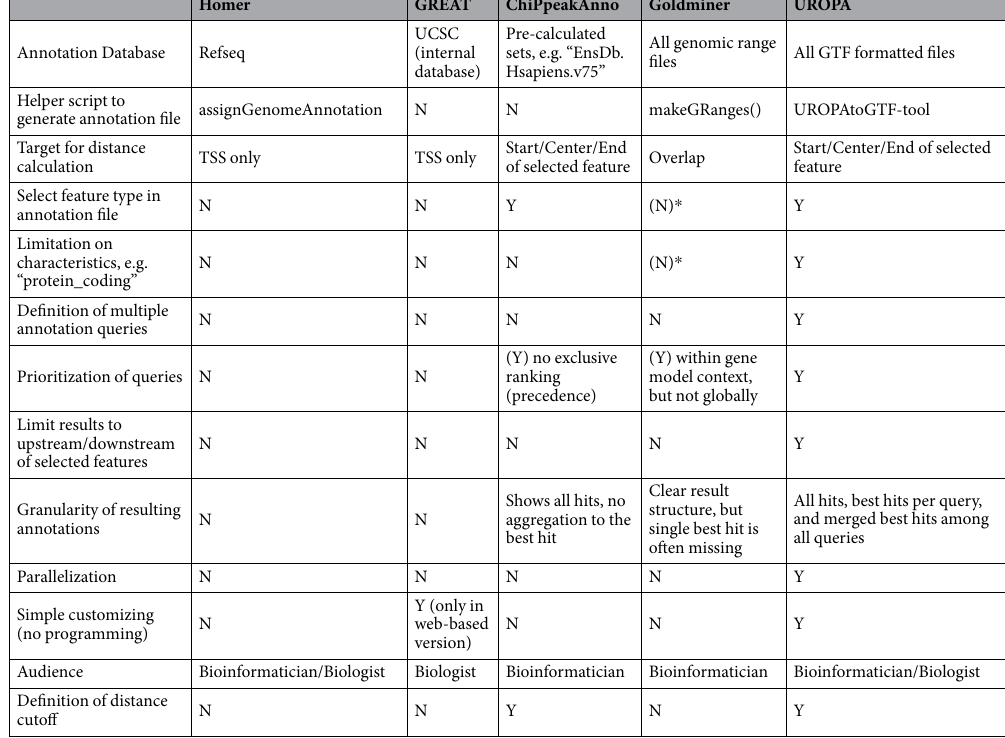
Table 1. Comparison matrix of popular annotation tools: the first column defines features supported by the respective tools given in column 2–5. Available/not available features are coded as Y or N, respectively. In case of comparable features, explanations/details are given as key words. * Indicates “only via additional